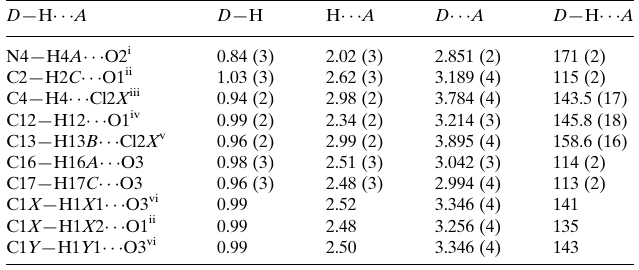
Hydrogen-bond geometry (A˚ , (cid:3) ). D —H (cid:2)(cid:2)(cid:2)